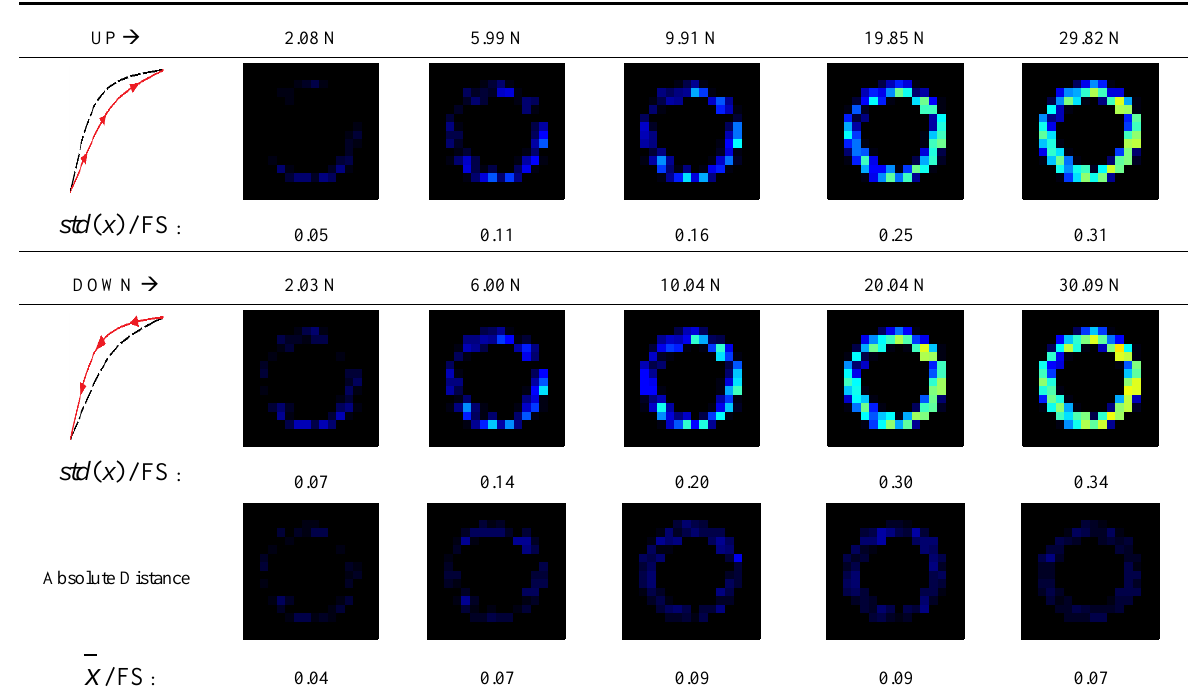
Table 8. Hysteresis loop frames measured before compensation with Ring object.